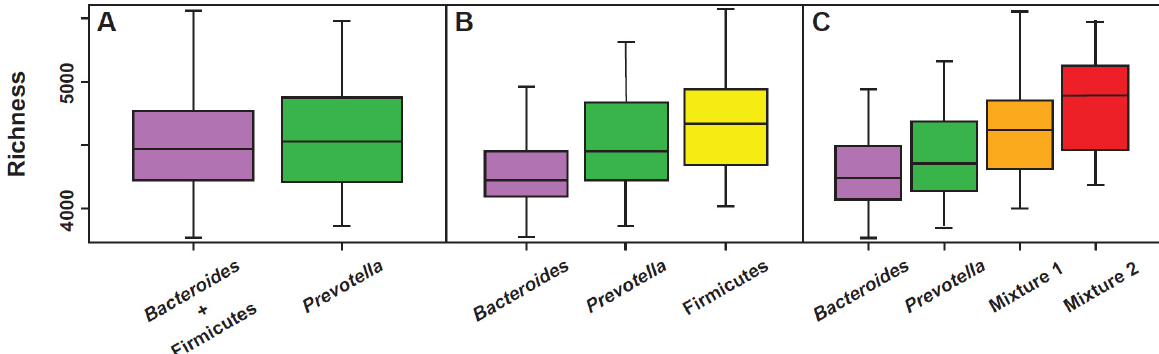
Figure 3. Relationship between functional richness and gut microbiota clusters evaluated according to the models that consider the existence of 2 ( A ), 3 ( B ), or 4 ( C ) clusters. Modified from [19].